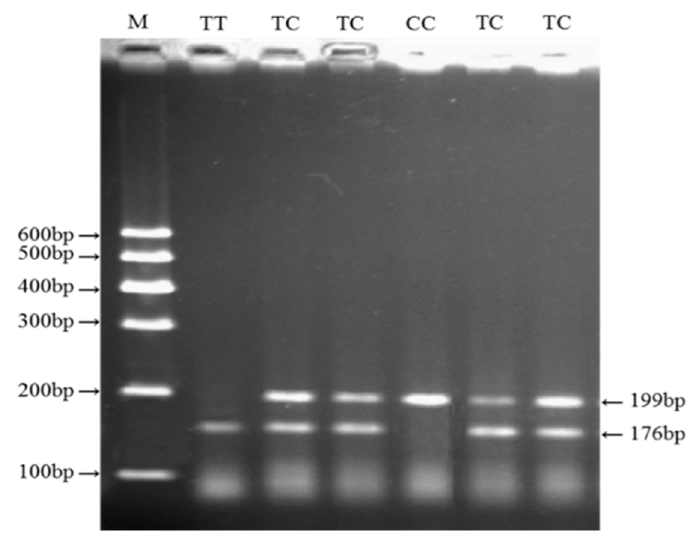
Figure 2. Polymerase chain reaction-restriction fragment length polymorphism (PCR-RFLP) of g.35989944T>C by agarose gel electrophoresis.